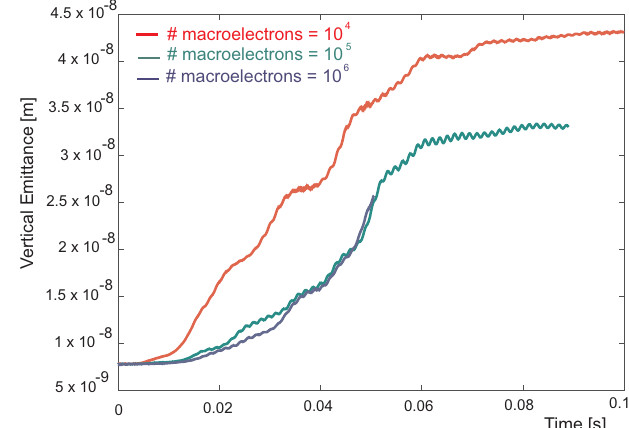
FIG. 3. (Color) Emittance as a function of time for different numbers of